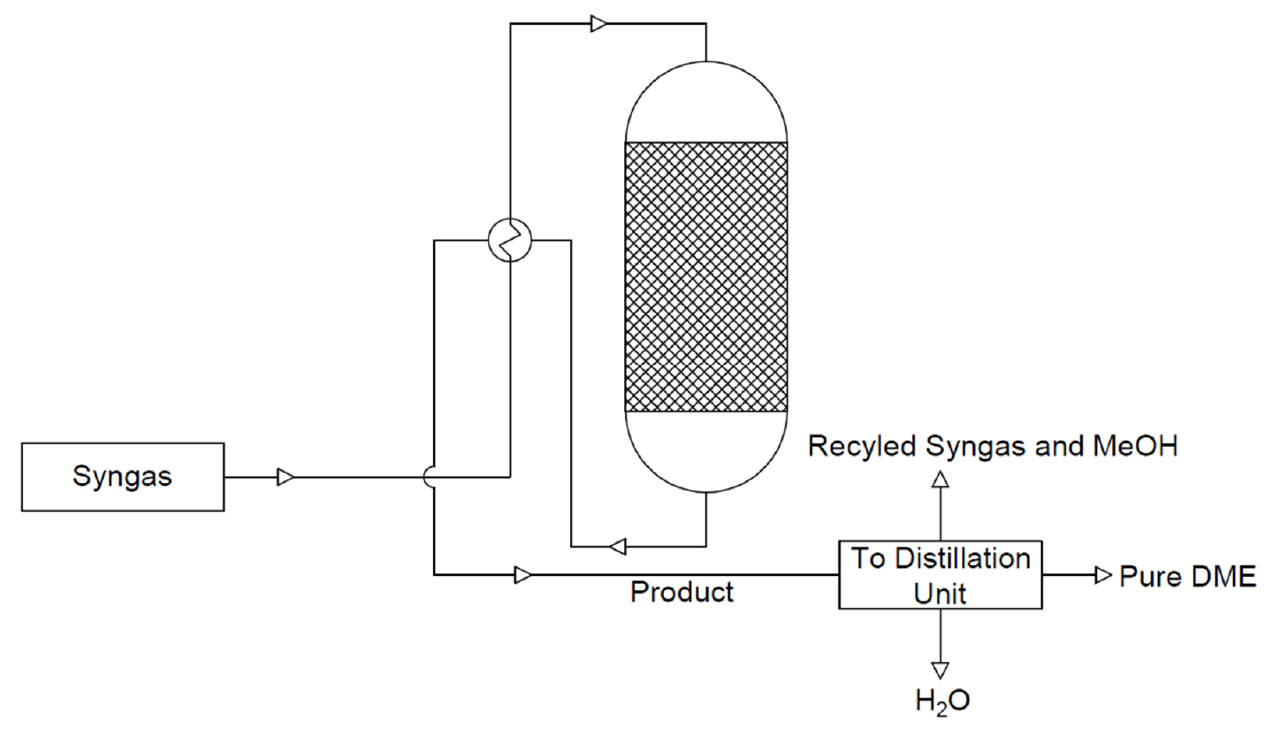
Figure 9. Scheme of a fixed-bed reactor. Developed based on [1].